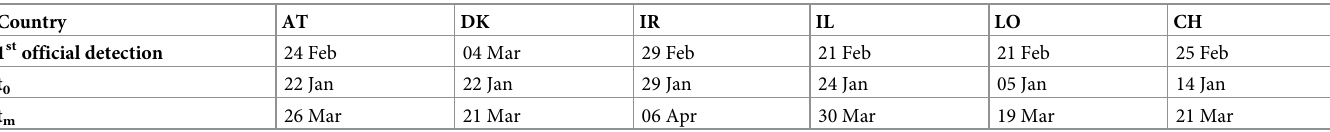
Table 3. COVID-19 significant